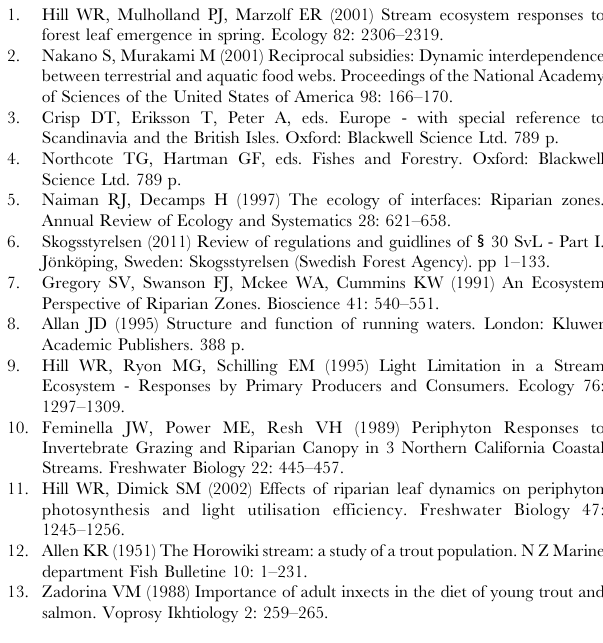
Table S1 Trout diet. Seasonal changes in the frequency of occurrence (O%) and mean relative biomass (A%) of the most important food items in the diet of young (Y) and old (O) trout in unmanipulated (U), light (L), terrestrial invertebrate reduction (T R ) and terrestrial invertebrate reduction and light (T R L) treatments throughout the study period. Chironomidae* refers to all taxa except